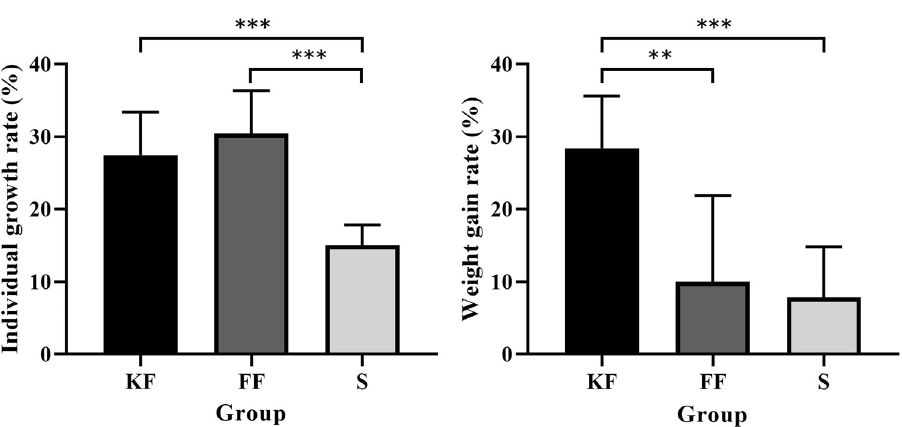
Figure 3. Individual growth rates of Apostichopus japonicus in the three groups (mean ± SD, N = 8, left). Weight gain rate (WGR) of Apostichopus japonicus in the three groups (mean ± SD, N = 8, right). KF, FF, S refer to group KF, group FF and group S. The asterisks ** and *** mean P < 0.01 and P < 0.001, respectively.